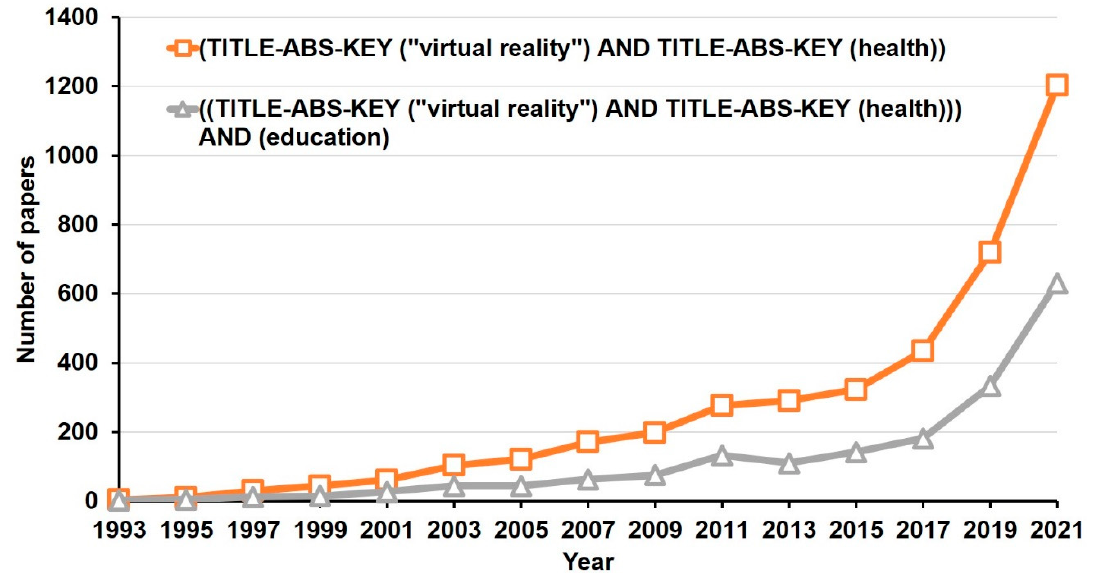
Figure 2. Number of research papers indexed in SCOPUS related to virtual reality, health, and education (data collected in September 2022).